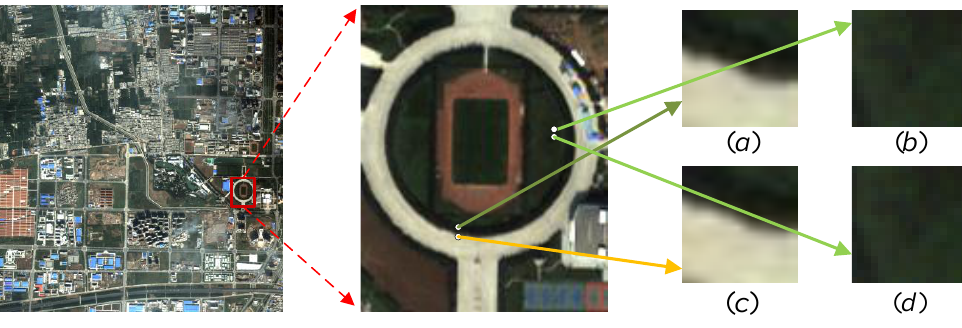
Figure 1. The overall process of traditional pixel-central sample sampling. ( a , c ) are sample patches that are similar but do not belong to the same category; ( b , d ) are sample patches of the same category but with closer Euclidean